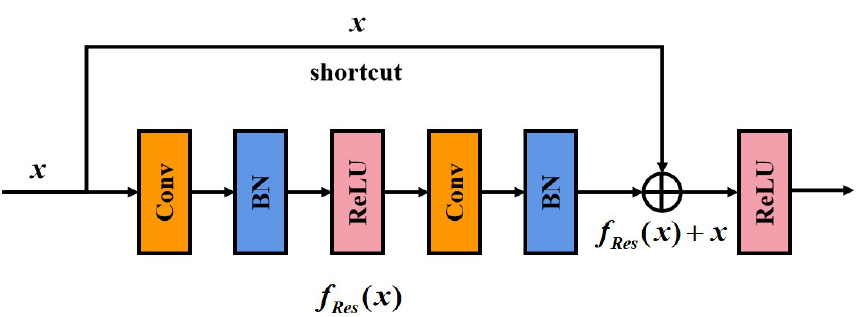
Figure 3. The structure of the basic residual unit. BN and Conv represent the batch normalization layer and convolutional layer, respectively, and ReLU is the activation